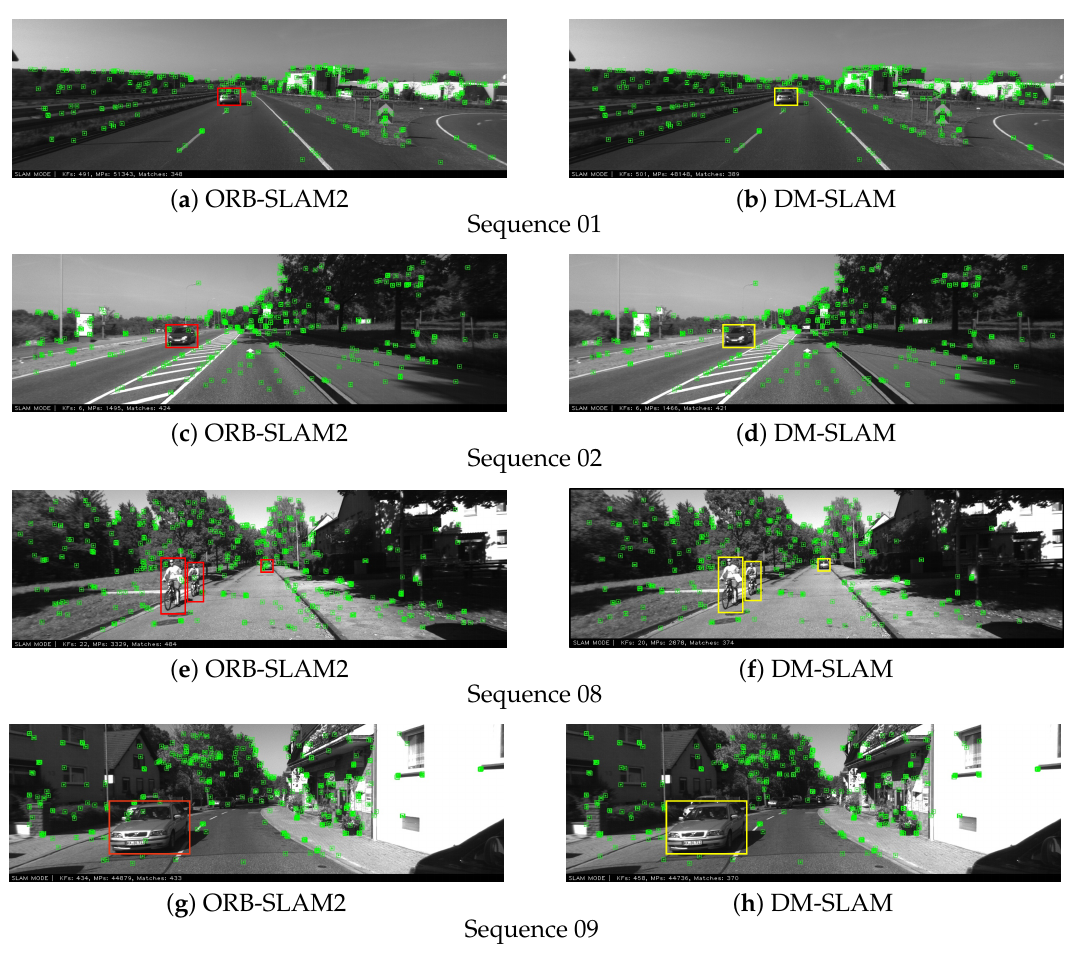
Figure 10. Tracking experiments with ORB-SLAM2 and DM-SLAM on the 01, 02, 08, and 09 sequences. The rectangular boxes represent the moving objects, and there are some feature points tracked in the red box of ORB-SLAM2 but not in the yellow box of